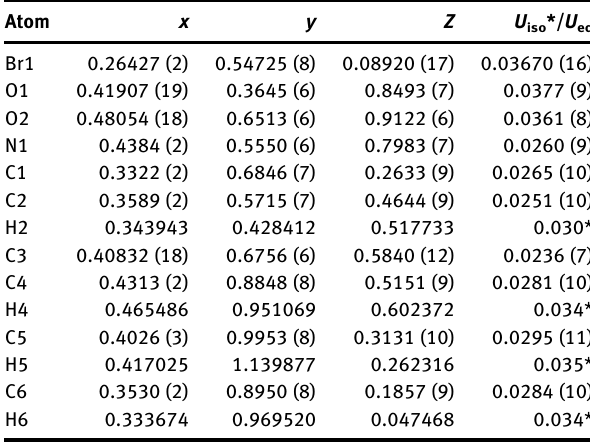
Table  : Fractional atomic coordinates and isotropic or equivalent isotropic displacement parameters (Å  ).